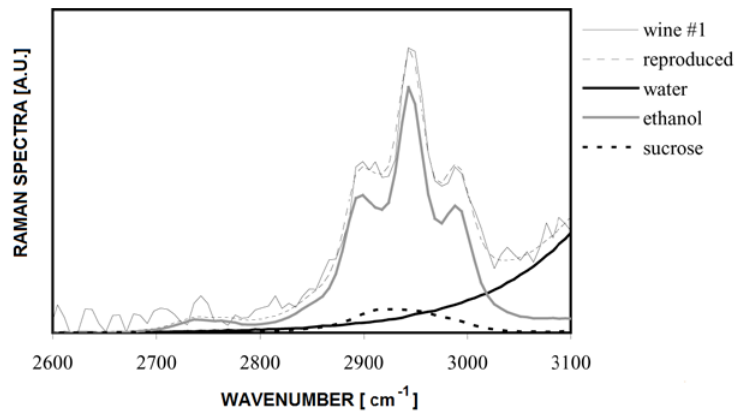
Figure 20. Raman spectra of wine